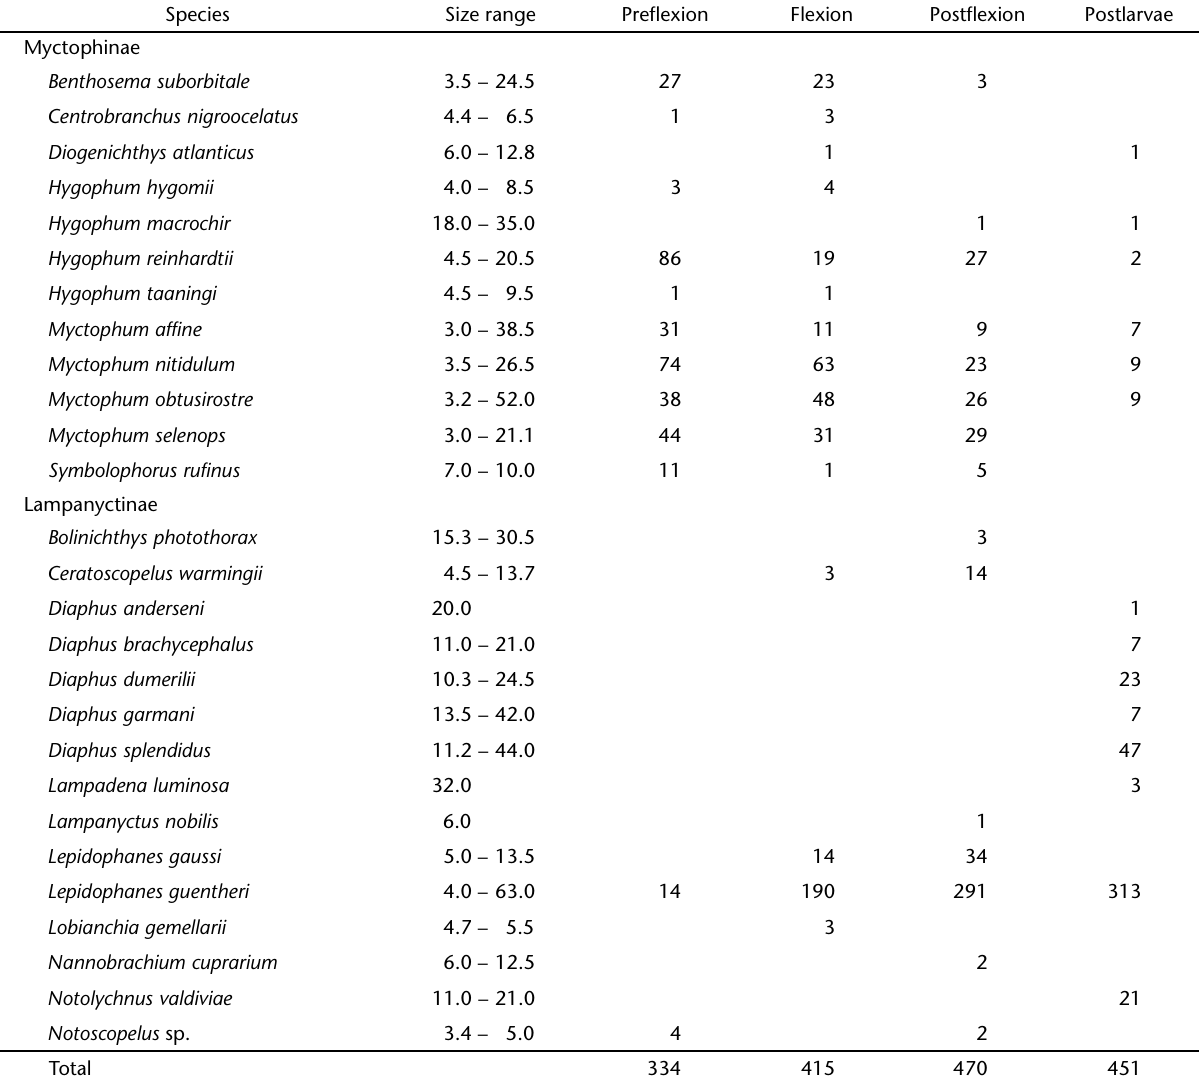
Table III. Size range (mm SL) and number of larvae collected during the three cruises, in each development stage.